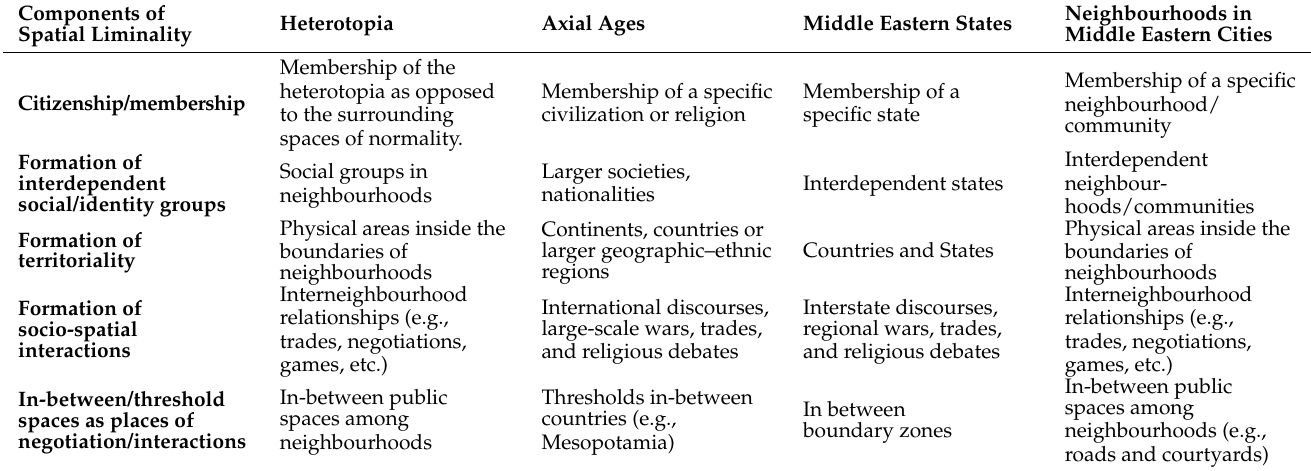
Table 1. Five essential elements of spatial liminality, as developed in this